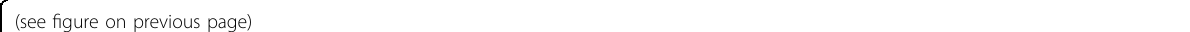
Fig. 6 mTOR silencing correlates with reduced fraction of cancer stem-like cells in vivo. a Graph and fl ow plots depicting the percentage of ALDH high CD44 high cells identi fi ed by fl ow cytometry in tumors generated upon transplantation of mTOR-silenced or scrambled vector control UM- HMC-3B cells ( n = 6 tumors per experimental condition) 90 days after transplantation of tumor cells into the subcutaneous space of immunode fi cient mice. t -test was used for statistical analyses of the data. b Western blot analyses for mTOR, p-S2448-mTOR, S6K1, p-T421/S424-S6K1, and Bmi-1 expression in lysates from each individual tumor generated by transplantation of mTOR-silenced or vector control cells (UM-HMC-3B) into immunode fi cient mice ( n = 6). c Graph depicting regression analysis of volume of tumors generated with mTOR-silenced cells (blue line) or vector control cells (black line). Open black circles represent the volume of each individual tumor, and black line the average volume of tumors generated with shRNA-Control cells. Solid blue circles represent the volume of each individual tumor, and blue line the average volume of tumors generated with shRNA-mTOR cells. d Graph depicting fi nal weight of tumors generated by the transplantation of shRNA-mTOR or shRNA-control cells into mice at the end of the experiment (90 days). e Image of all xenograft tumors generated by mTOR-silenced or vector control tumor (UM-HMC-3B) cells at the time of mouse euthanasia. f Immunohistochemical analyses for p-S6K1 or Factor VIII in mTOR-silenced or vector control xenograft tumors (UM- HMC-3B). g , h Graphs depicting the quanti fi cation of p-S6K1-positive cells ( g ) and Factor VIII-positive blood vessels ( h ), as determined by quanti fi cation of fi ve microscopic fi elds per tumor by an investigator blinded for experimental conditions. Images were taken at 200×. Scale bars represent 25 µm. Error bars indicate standard